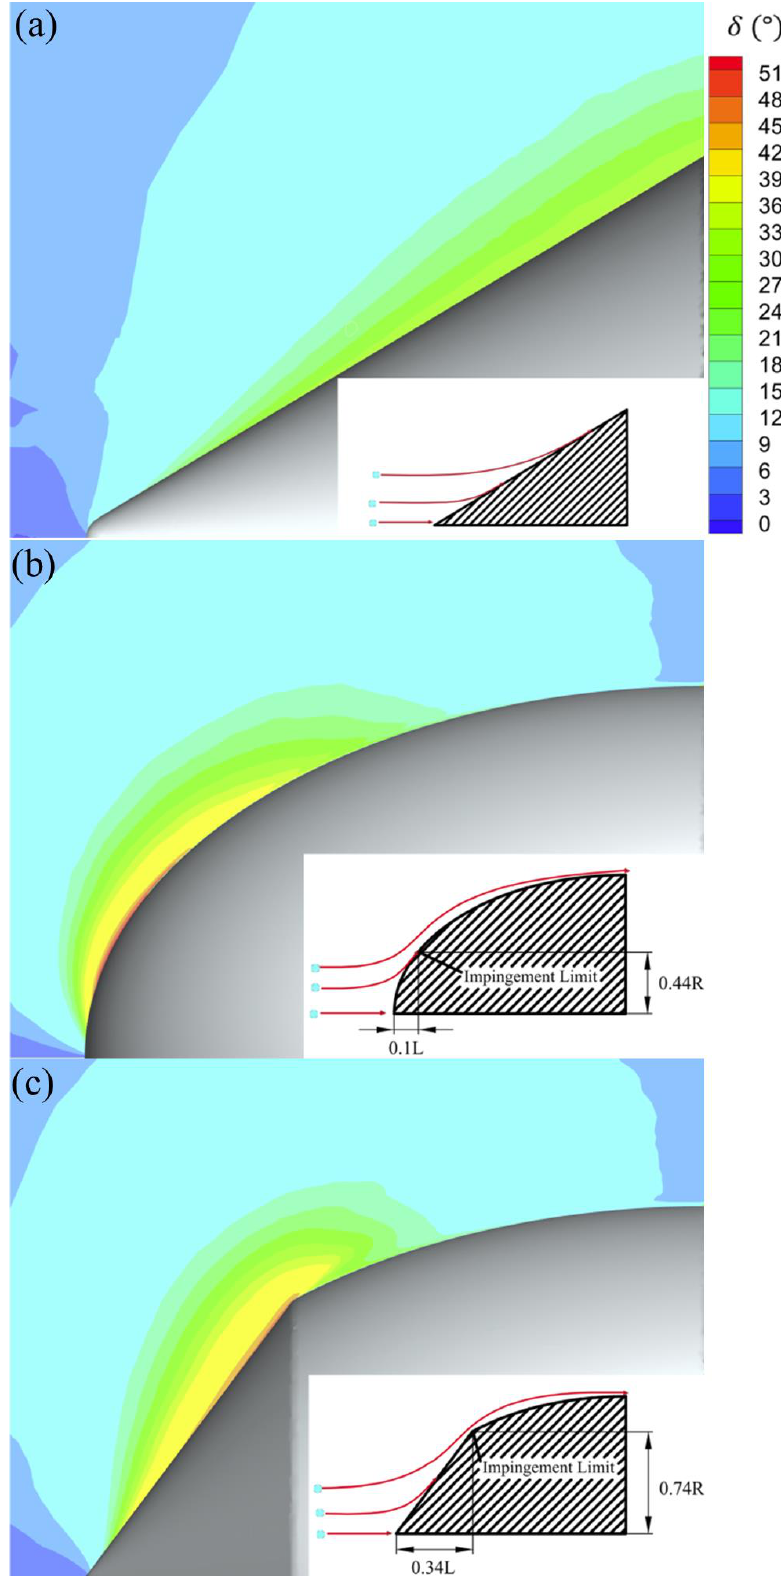
Figure 9. Distribution of the angle, 𝛿, of water droplets: ( a ) conical spinner; ( b ) elliptical spinner; ( c ) coniptical spinner.